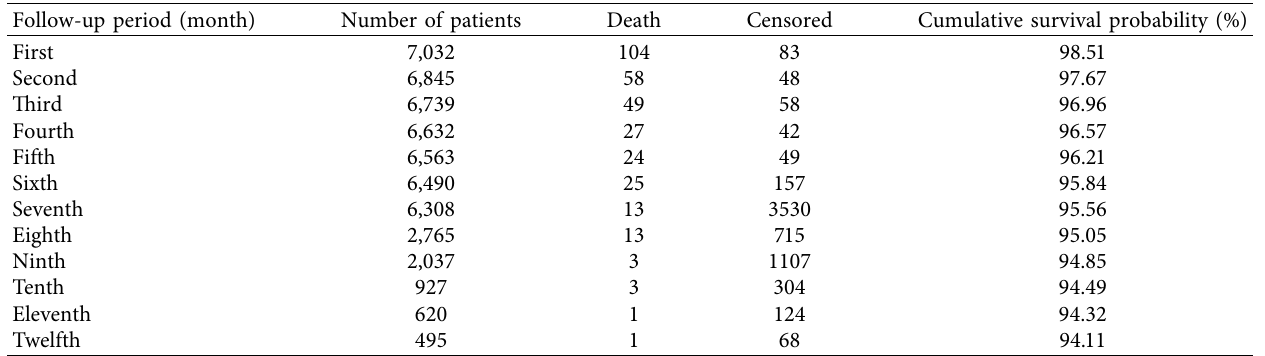
Table 1: Survival probabilities throughout the course of treatment in 7,032 tuberculosis patients.